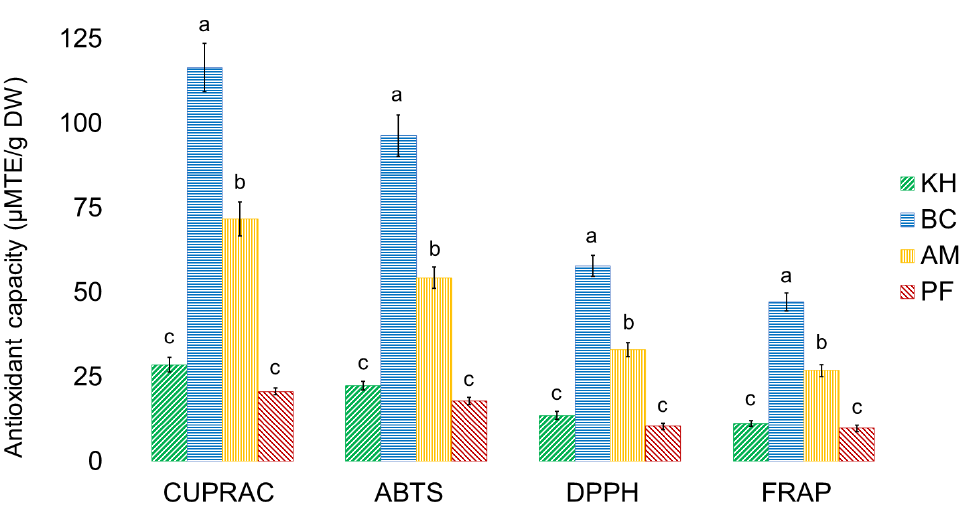
Figure 6. Antioxidant capacities in kiwifruits and persimmons. Values are ± SD per gram of dry weight (DW); n = 5 samples per cultivar, each subsampled and analyzed 5 times. Values in bars with different superscript letters are different between the groups of investigated fruit samples in each independent analysis of their quality ( p < 0.05). Abbreviations: KH, Actinidia (A.) deliciosa cv. Hayward; BC, A. eriantha cv. Bidan; AM, A. arguta cv. Cheongsan; PF, Diospyros kaki Thunb. cv. Fuyu; CUPRAC, Cupric reducing antioxidant capacity; ABTS, 2, 2-Azino-bis (3-ethyl-benzothiazoline-6-sulfonic acid) diammonium salt; DPPH, 1, 1-Diphenyl-2-picrylhydrazyl method; FRAP, Ferric-reducing/antioxidant power; TE, Trolox equivalent.